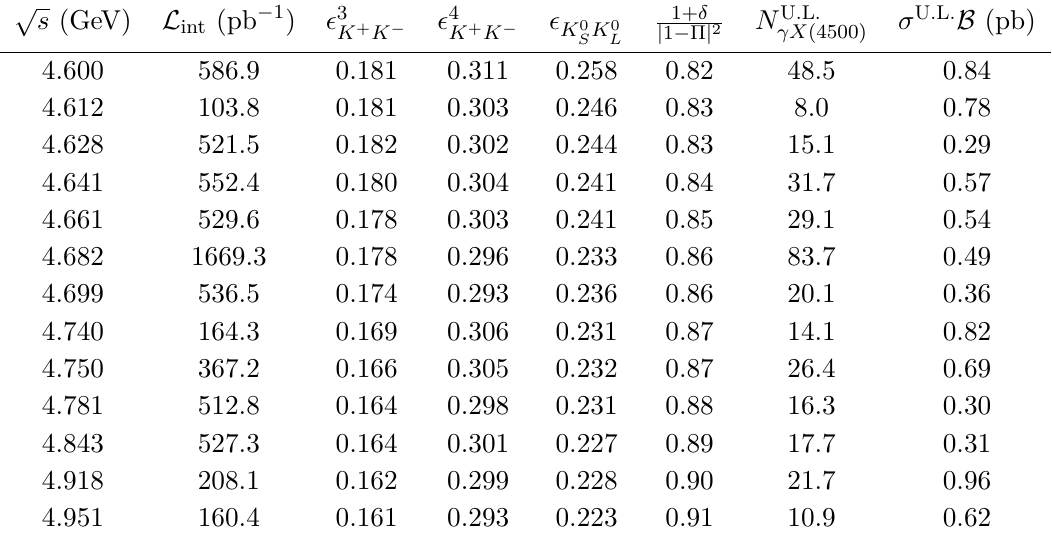
Table 11 . The upper limit of Born cross section at 90% C.L. σ U . L . B ( X → φJ/ψ ) for e + e − → √ γX (4500) at each c.m. energy s . The table also includes integrated luminosity L int , detection